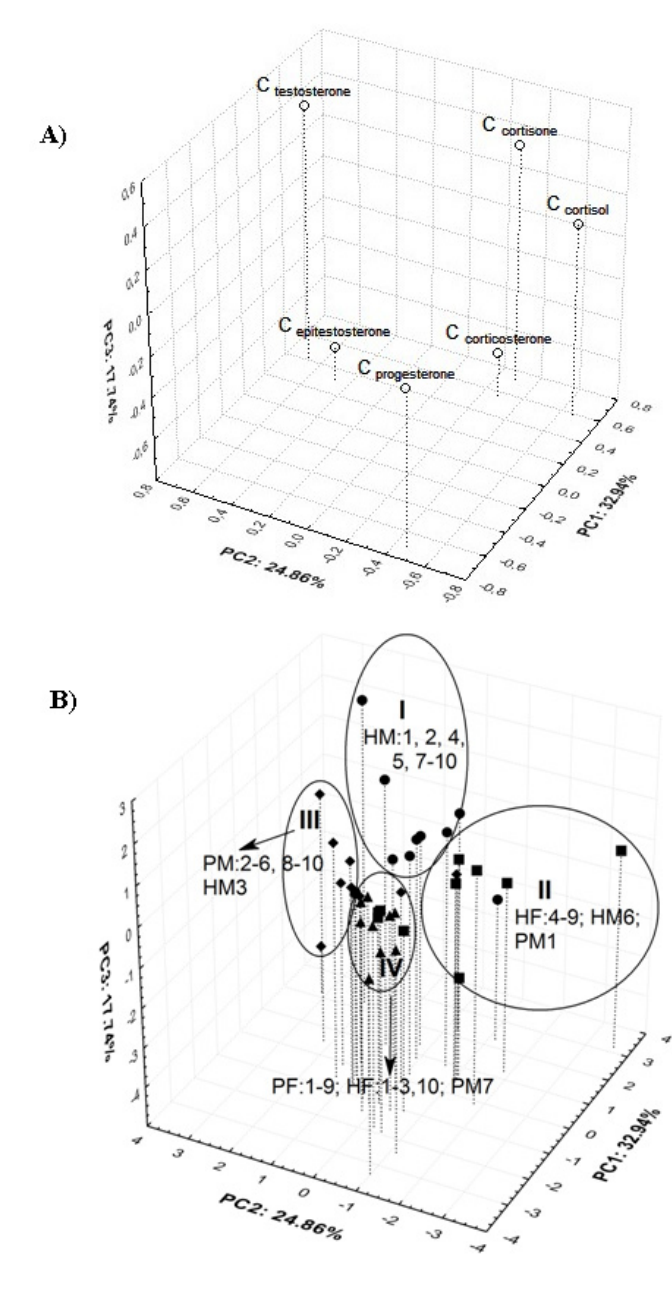
Figure 4. The projection of the variables ( A ) and the subjects ( B ) into a three-dimensional space created by PCA based on six urinary free steroid profiles determined for the investigated